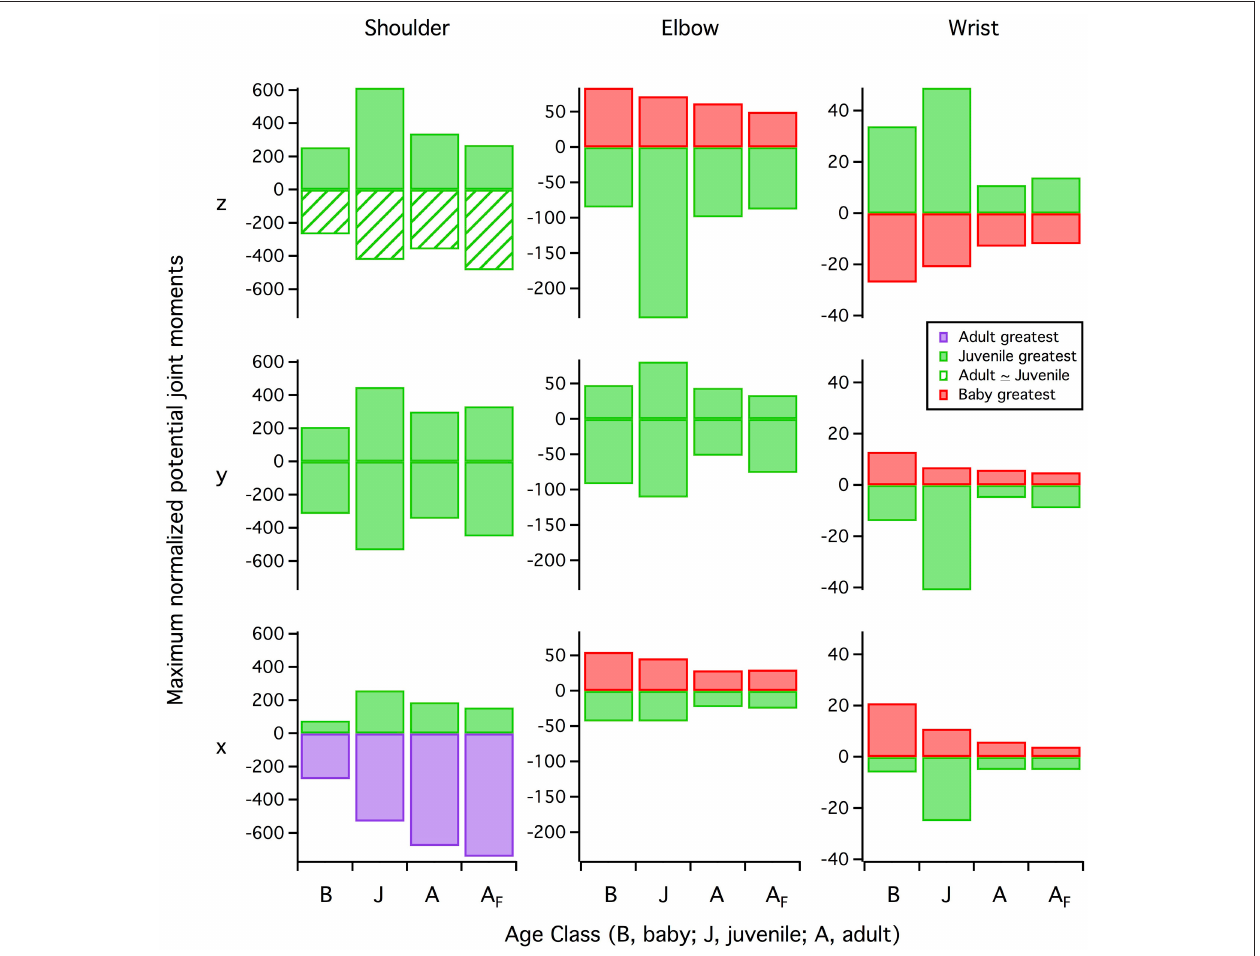
FIGURE 12 | Maximum potential joint moments. Maximum potential joint moments (positive or negative muscle moment arms (in z, y, and x directions) multiplied by maximum isometric muscle force, summed for all muscles at each 1% of the stroke cycle, then averaged over the stroke cycle and normalized by notarium length and body weight) are greatest in the juvenile model for more than half of the possible joint motions. Red bars, baby has the greatest (most positive or most negative) joint moment; green bars, juvenile has the greatest joint moment; green hashed bars, juvenile and adult have similar joint moments; purple bars, adult has the greatest joint moment. Row z, elevation ( + moments) vs. depression ( − ) (shoulder joint) or extension ( + ) vs. flexion ( − ) (elbow, wrist); row y, protraction ( + ) vs. retraction ( − ) (shoulder) or abduction ( + ) vs. adduction ( − ) (elbow, wrist); row x, supination ( + ) vs. pronation ( − ) (all joints). B, baby model (7–8 days); J, juvenile model (18–20 days); A, adult model ( > 100 days) during wing-assisted incline running; A F , adult model during ascending flight, for